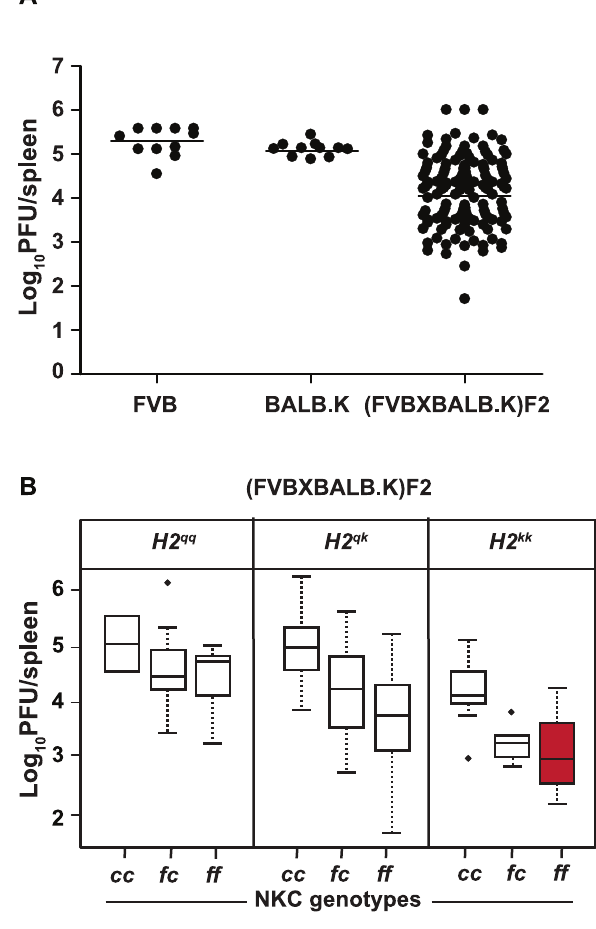
Figure 2. MCMV resistance in FVB/N 6 BALB.K F 2 progeny dependent on specific combinations between the NKC and H2 . (A) Genetic analysis of MCMV infection control in FVB/N 6 BALB.K F 2 progeny. Mice (FVB/N and BALB.K, n =11 per strain; FVB/N 6 BALB.K F 2 , n =137) were infected with 5,000 PFU of MCMV; the spleen viral titers were determined by plaque assay at day 3 p.i. (B) Box plots show the combined effect of the NKC and H2 loci derived from FVB/N ( H2 qq and NKC ff ) or BALB.K ( H2 kk and NKC cc ) parental mice on the viral loads in the spleens of the F 2 progeny. The median and interquartile ranges are shown. Solid dots denote outliers. The red box corresponds to the combination of NKC ff and H2 kk loci ( P , 6 6 10 2 11 ). doi:10.1371/journal.pgen.1001368.g002 transgenic mice were double those of hemizygous H2 0/q /Tg(D k ) + transgenic mice ( P = 0.001) (Figure 4B and bar graph). Despite this variation in MHC class I expression levels, licensing of NK cells from H2-D k transgenic mice carrying no ( 0 ), one ( 0/q ), or two ( q/q ) Table 2. ANOVA of MCMV load in spleens from (FVB/ N 6 BALB.K) F 2